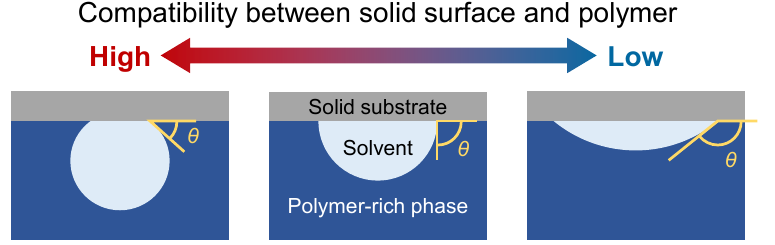
Figure 1. Schematic of contact angle representing compatibility between solid surface and polymer.